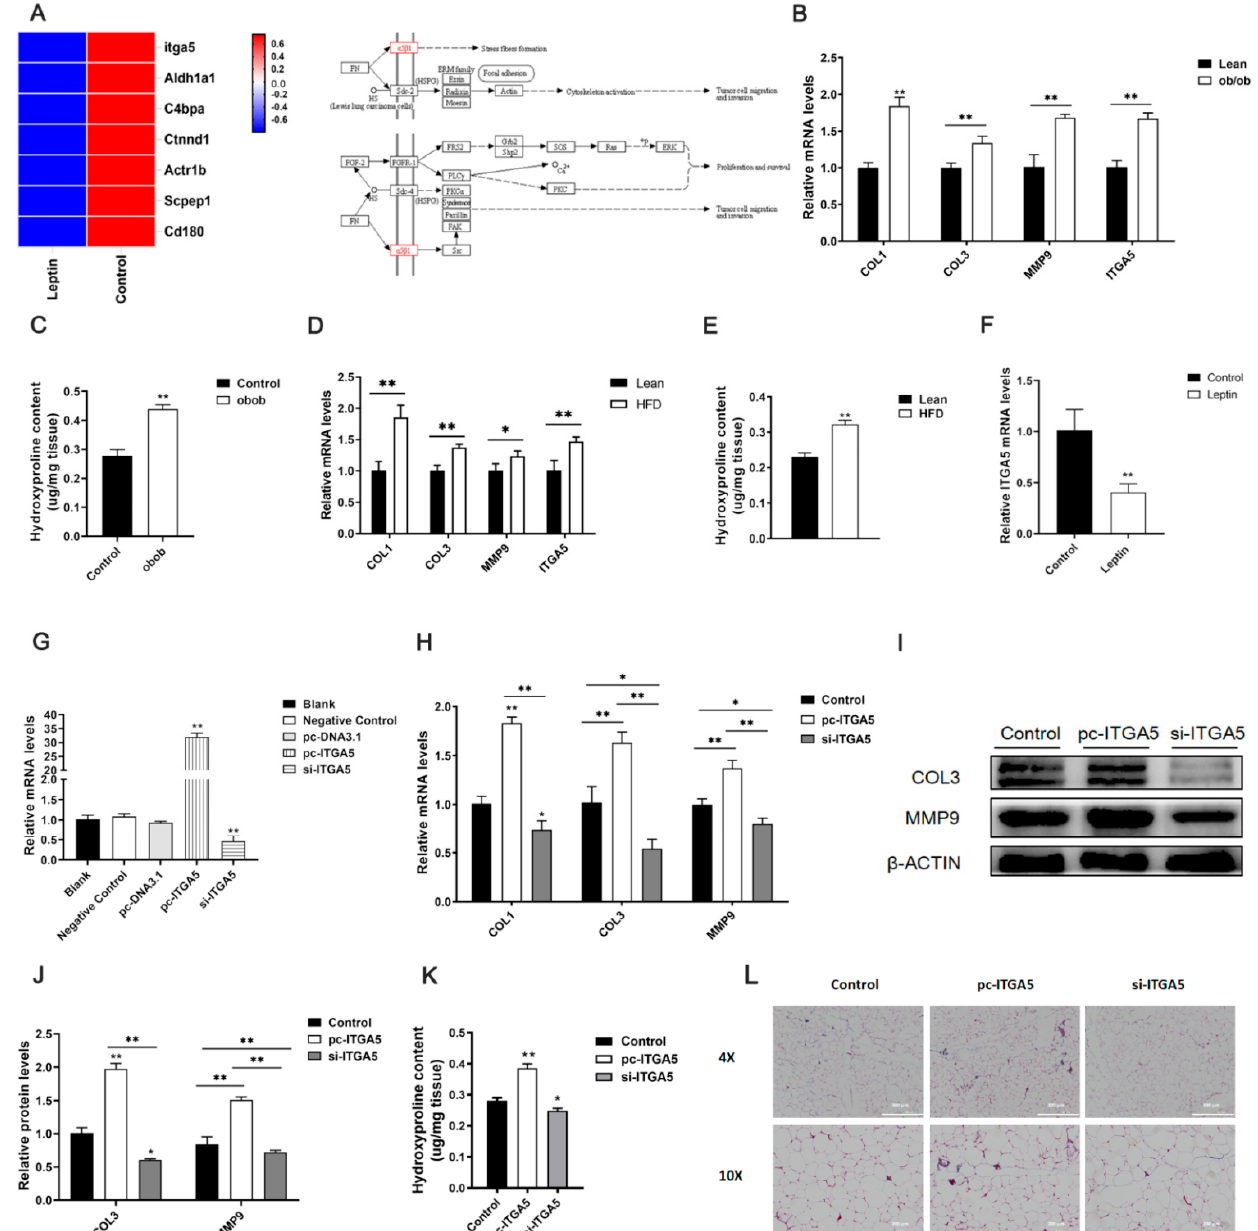
Figure 2. Leptin relieves adipose tissue fibrosis by inhibiting ITGA5. ( A ) Proteomics sequencing analysis ( n = 4). ( B ) The relative mRNA expression levels of ob/ob mice adipose tissue fibrosis-related genes COL1, COL3, MMP9, and ITGA5 ( n = 4). ( C ) The relative content of hydroxyproline in adipose tissue of ob/ob mice ( n = 4). ( D ) The relative mRNA expression levels of adipose tissue fibrosis-related genes COL1, COL3, MMP9, and ITGA5 in HFD mice ( n = 4). ( E ) The relative content of hydroxyproline in adipose tissue of HFD mice ( n = 4). ( F ) Afterwards, it is treated with leptin, the relative expression levels of ITGA5 mRNA in mice adipose tissue ( n = 4). ( G ) After interference and overexpression of ITGA5 in mice, the expression efficiency of ITGA5 in adipose tissue ( n = 4). ( H ) After interference and overexpression of ITGA5 in mice, relative mRNA expression levels of adipose tissue fibrosis-related genes COL1, COL3, MMP9 ( n = 4). ( I , J ) After interference and overexpression of ITGA5 in mice, the relative mRNA expression levels of adipose tissue fibrosis-related genes COL3, MMP9 ( n = 4). ( K ) After interference and overexpression of ITGA5 in mice, the relative content of hydroxyproline in adipose tissue ( n = 4). ( L ) After interference and overexpression of ITGA5 in mice, Masson staining of mouse adipose tissue, scale bar: 300 µ m, scale bar: 200 µ m ( n = 4). Values are means ± SD, * p < 0.05, ** p < 0.01 compared with the control